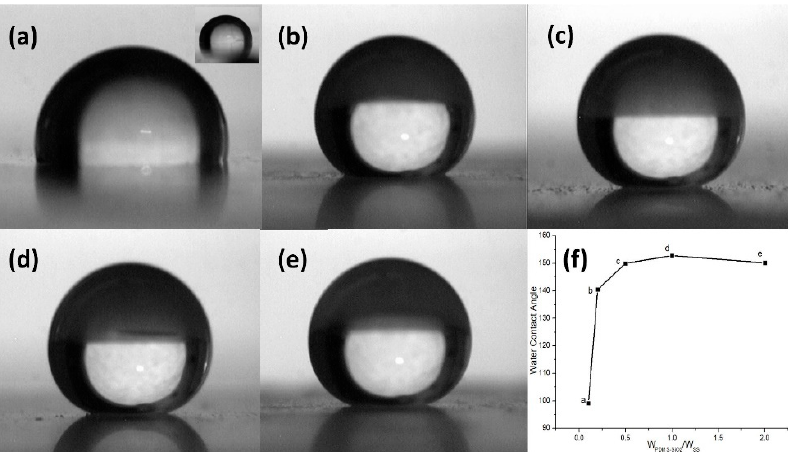
Figure 5. Water contact angles (WCAs) of PDMS-SiO 2 /SS hybrid coating with different mass ratios of PDMS-SiO 2 to SS. ( a ) 1:10; ( b ) 1:5; ( c ) 1:2; ( d ) 1:1; ( e ) 2:1. ( f ) WCA curve of PDMS-SiO 2 /SS hybrid coating with different mass ratio of PDMS-SiO 2 to SS. Inset image in ( a ) is the WCA of pure SS coating.